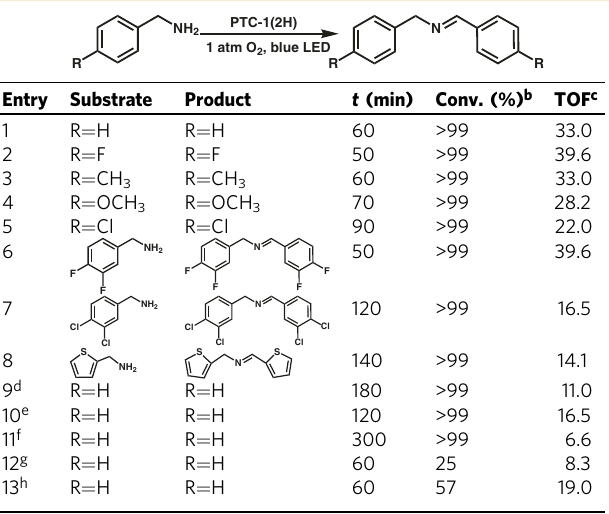
Table 3 Heterogeneous visible light oxidative coupling of various amines into imines a